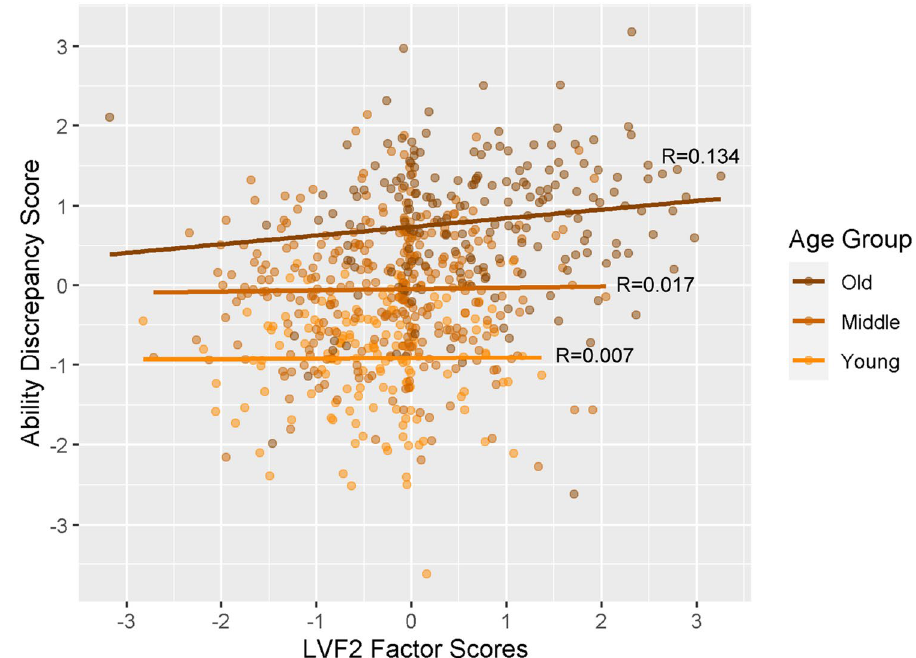
Figure 4. A visualisation of the effect of latent vascular factor 2, expressing predominantly pulse pressure, on the ability discrepancy for complete case data (n = 655). Note that age was a continuous variable for the interaction tested, but here participants are plotted as discrete groups of young (18–37 years, n = 154), middle (38–67 years, n = 307) and old (68–88 years, n = 194) for visualisation purposes only. LVF2 latent vascular factor